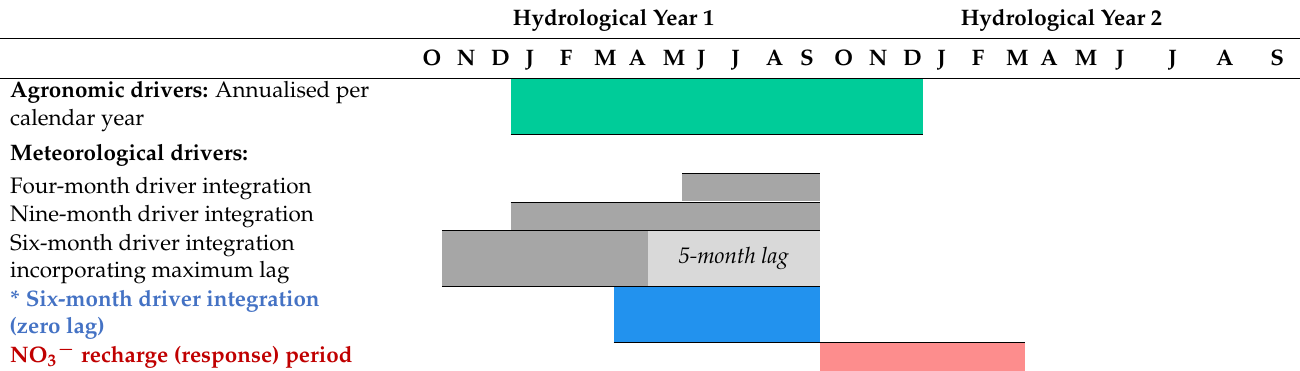
Table 5. Range of modelled driver and response integration periods over two hydrological